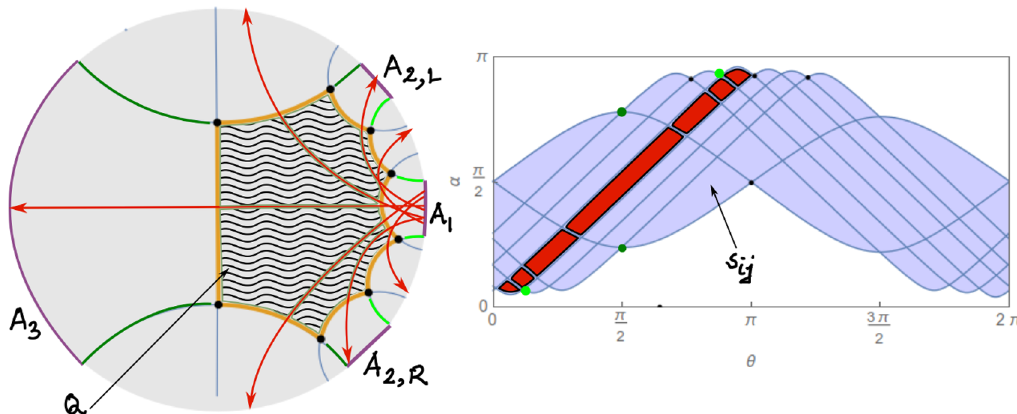
Figure 15. The region Q is the island arising for a three-exit (purple) wormhole. The geodesics which are identified by hyperbolic elements of the Fuchsian group are colored pairwise in light and dark green. Black dots in K correspond to event horizons. The colored region in K is K segments are the sectors s described in the text, of which we have s = 56 . We have higlighted ij sectors s for a fixed i and varying j 6 = i in ij